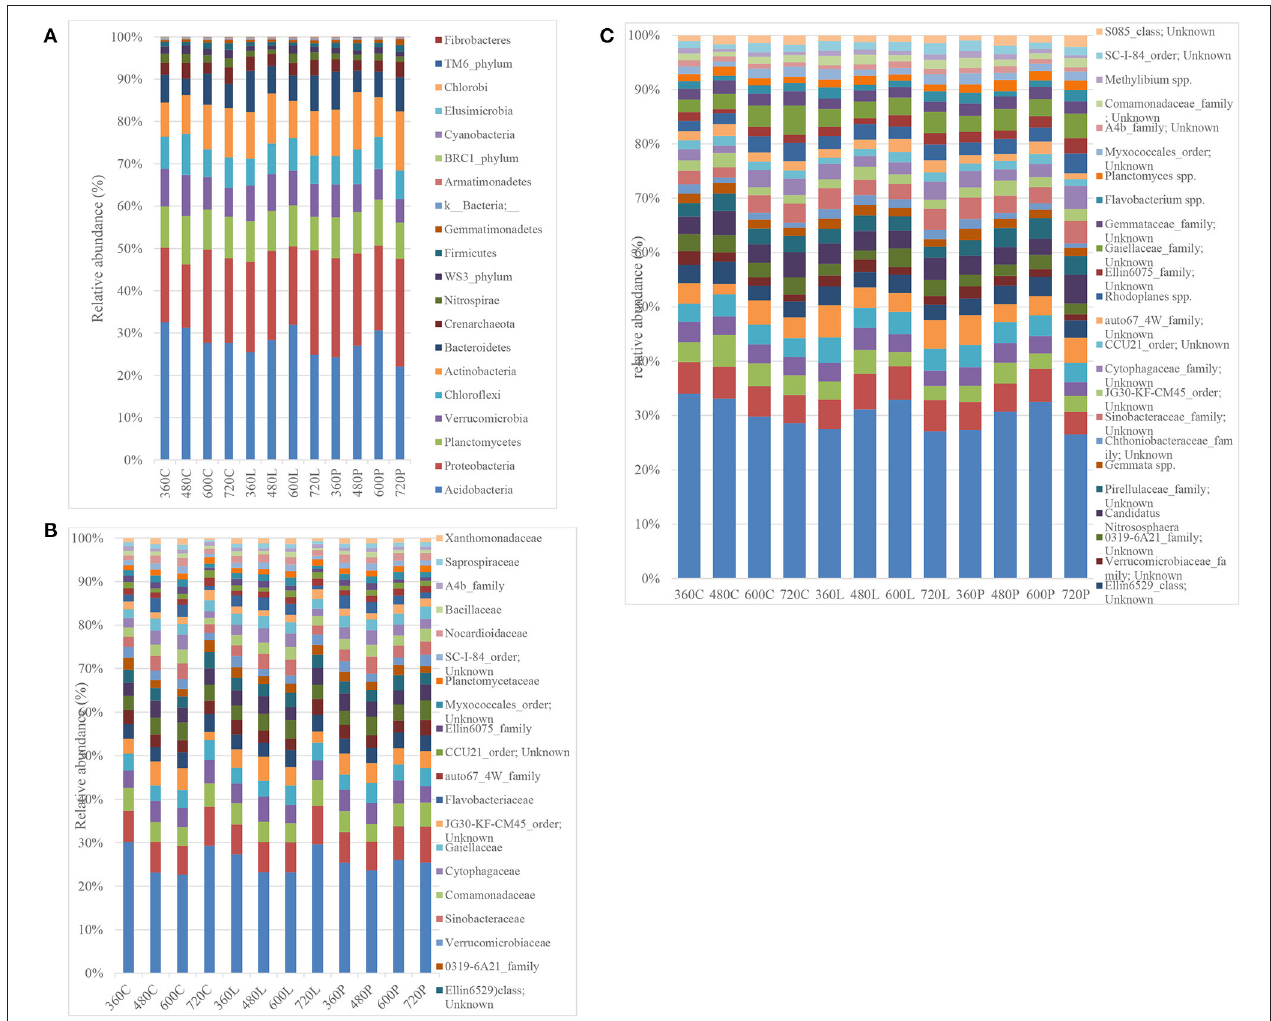
FIGURE 5 | Bacterial phylum-level (A) , family-level (B) , and species-level (C) resolution bar-plots of the control (C), leaf litter (L), and piglet (P) associated soils on days 360, 480, 600, and 720.